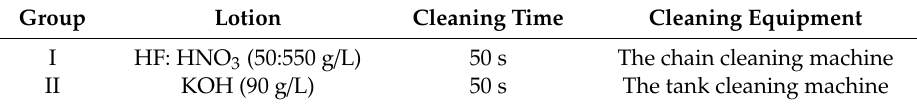
Table 2. The di ff erent cleaning schemes in the pre-cleaning step and subsequent